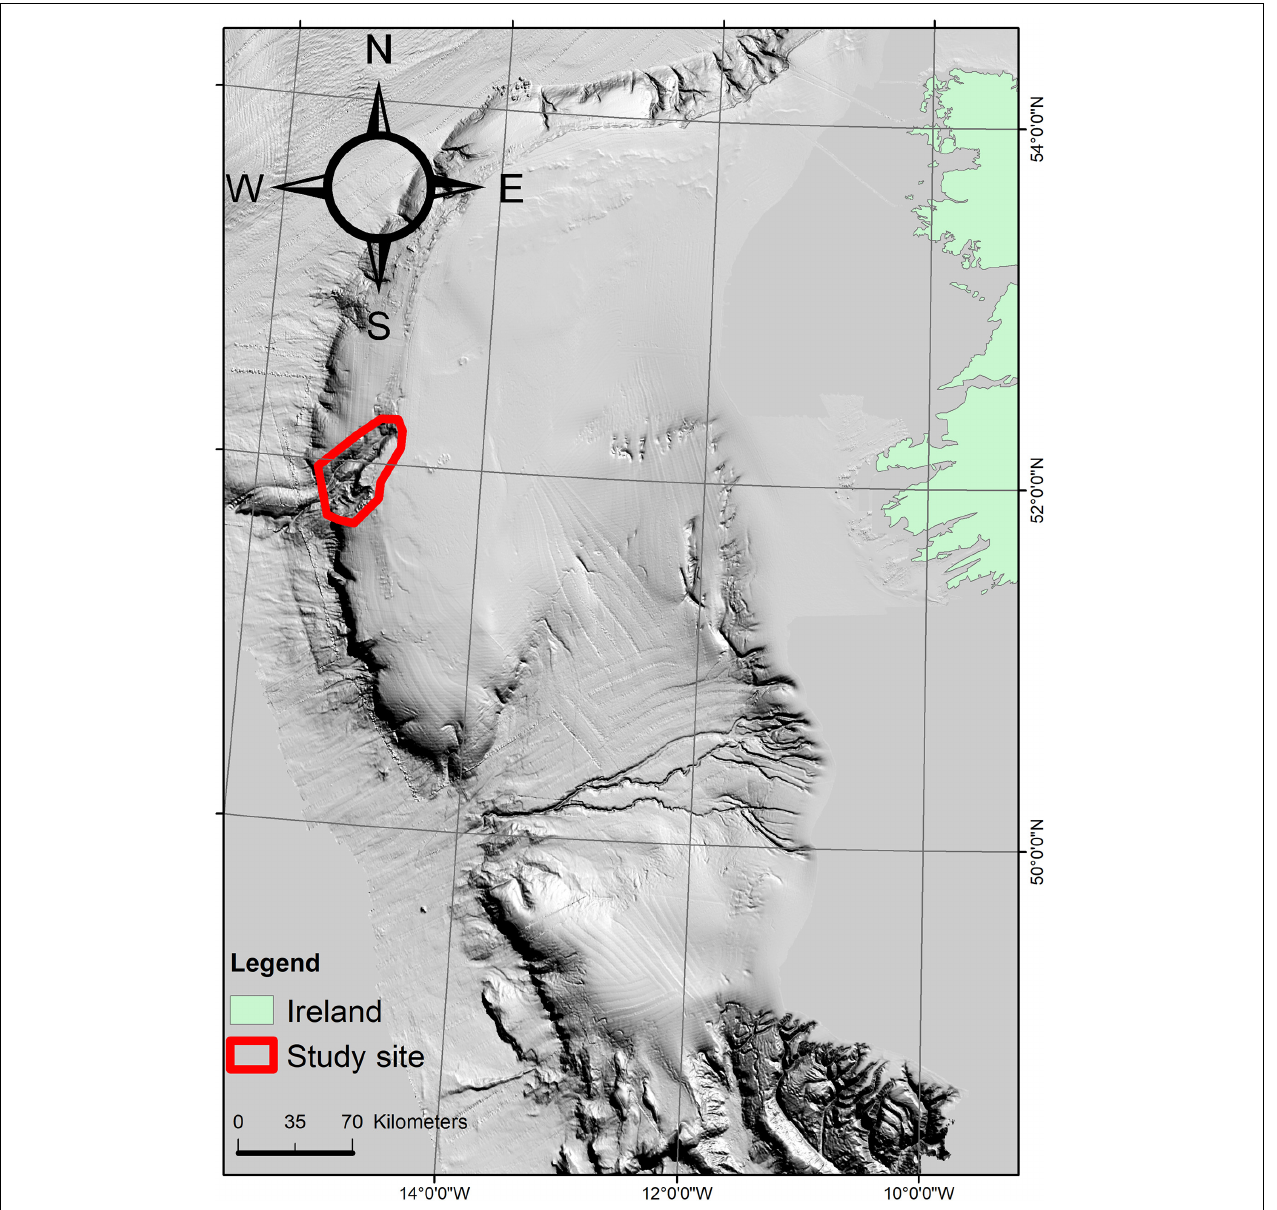
FIGURE 1 | Study site (in red)—The Porcupine Bank Canyon study area on the Irish continental margin west of